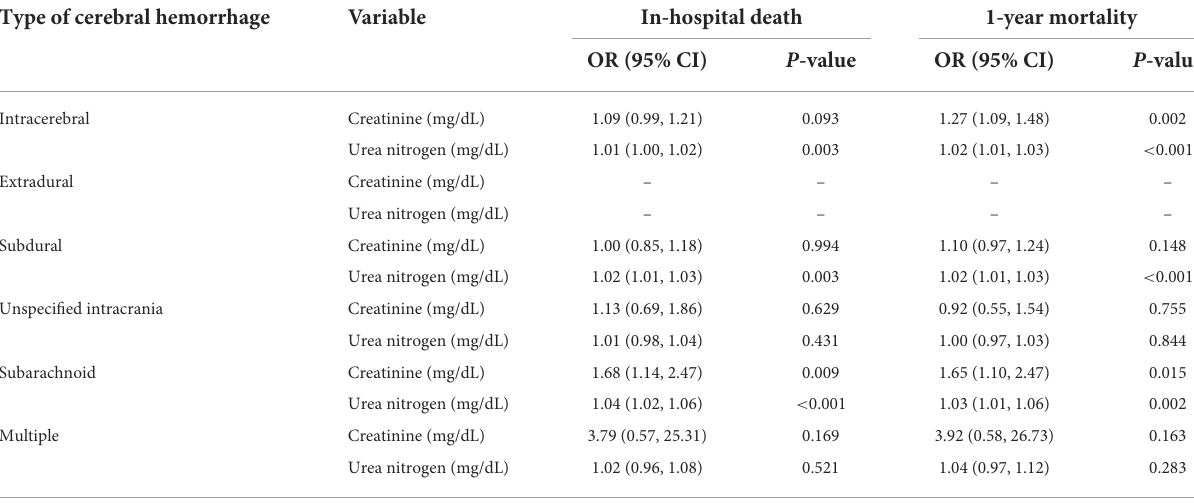
TABLE 4 Subgroup analysis by “type of intracranial hemorrhage” for associations of blood creatinine and urea nitrogen with hospital mortality and 1-year mortality in ICU patients in cerebral hemorrhage.